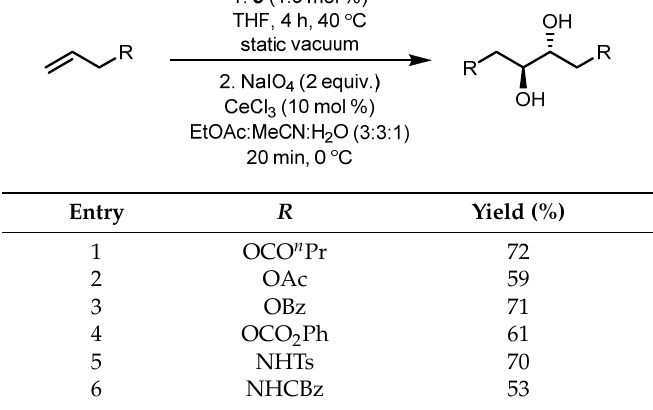
Table 21. Z -selective ethenolysis to furnish high E macrocyclic peptides.